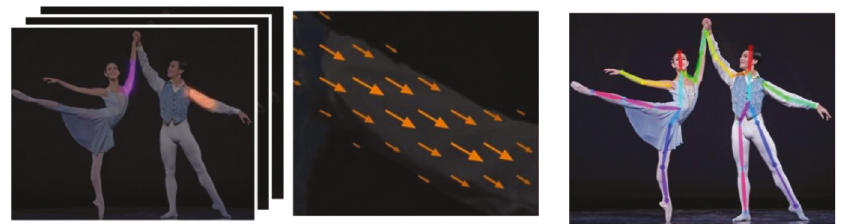
Figure 1: Principle of joint affinity field